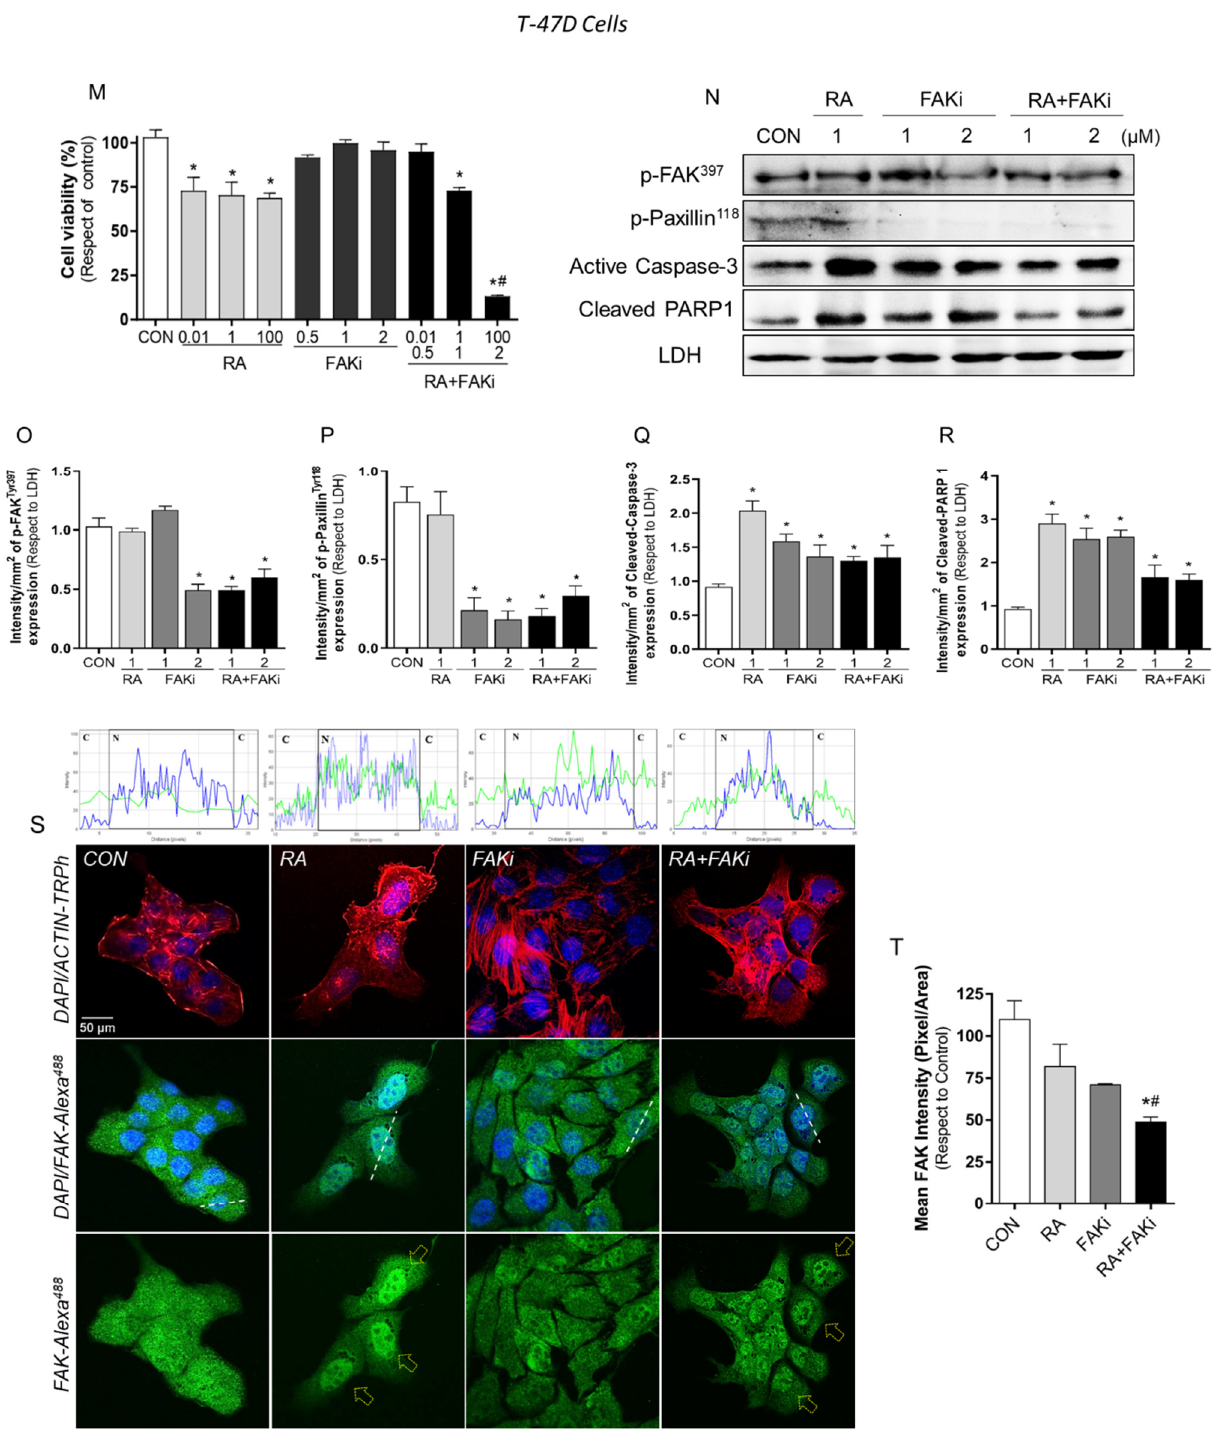
Figure 3. LM3 and T-47D cells viability and apoptosis. ( A ) LM3 cells were treated with increasing doses of RA (0.01–100 μ M), FAKi (0.5–2 μ M), and their combinations (0.01 μ M RA + 0.5 μ M FAKi), (1 μ M RA + 1 μ M FAKi) and (100 μ M RA + 2 μ M FAKi) for 72 h. The results were expressed as a percentage (%) of surviving cells compared to the control (CON, 100% survival). ( B ) LM3 cells were exposed with RA (1 μ M), FAKi (1–2 μ M) and their combinations (1 μ M RA + 1 μ M FAKi), (1 μ M RA + 2 μ M FAKi) for 72 h, and expression of RAR α , RAR β , RAR γ , FAK and Paxillin were analyzed by western blot assay. LDH expression is shown as a loading control. ( C – G ) Densitometric quantifica- tions of RAR α , RAR β , RAR γ , FAK and Paxillin bands. Intensity values were adjusted to the corre- sponding intensity values of LDH and then normalized to the control. ( H ) LM3 cells were exposed